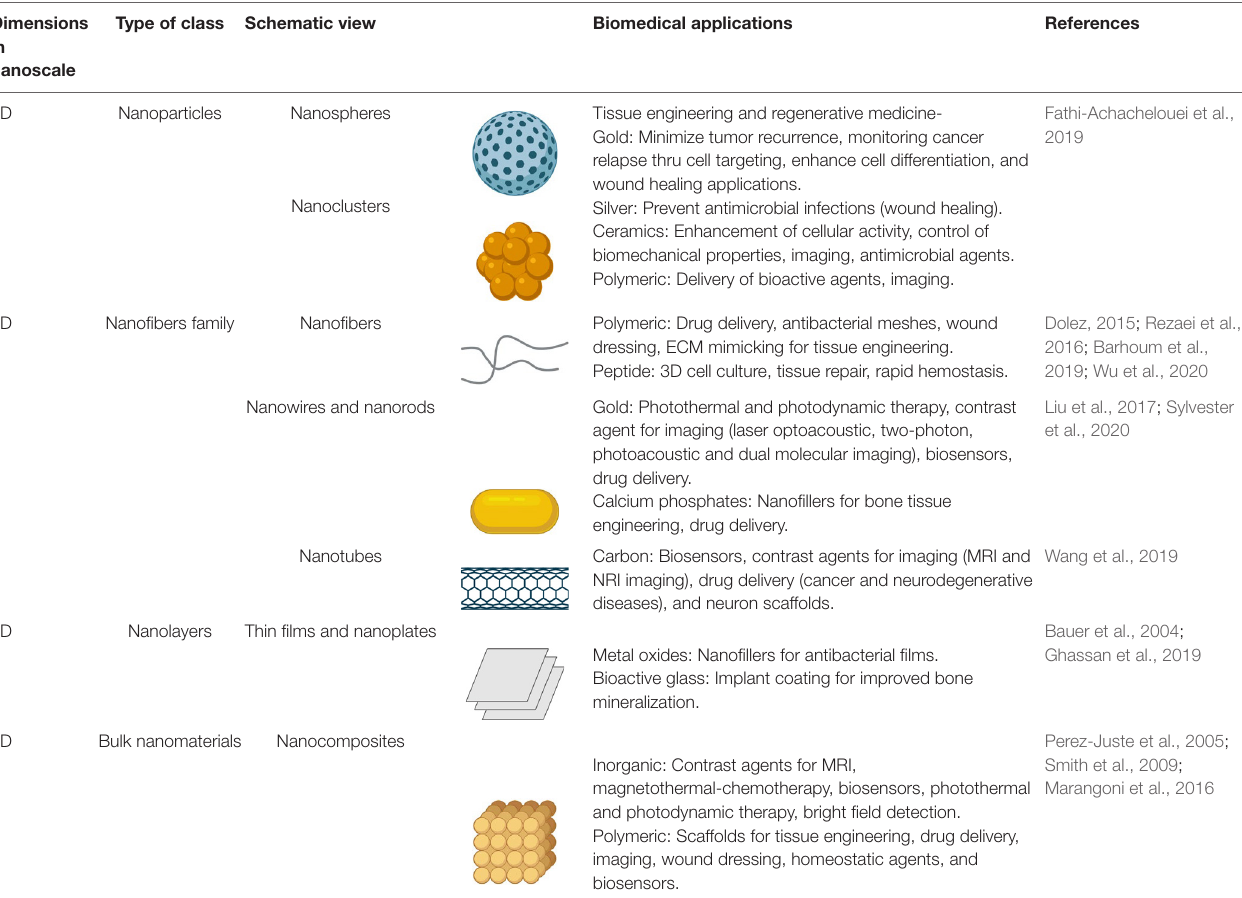
TABLE 1 | Nanomaterials classification is based on dimensions and their applications in biomedicine. Created with BioRender.com. Dimensions